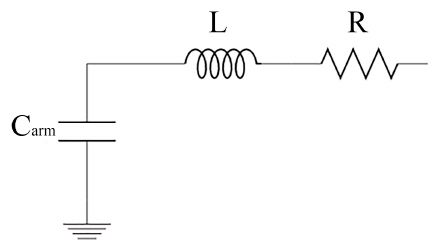
Figure 3. RLC model of converters .